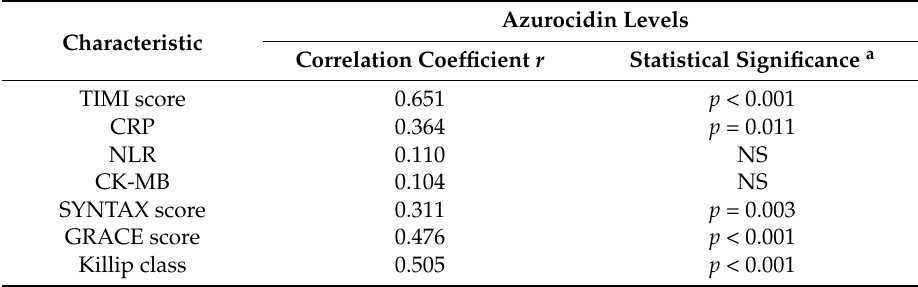
Table 2. Spearman’s rank correlation coefficient analysis of azurocidin levels with baseline demographic and clinical characteristics of patients ( n = 76) with ST segment elevation myocardial infarction.